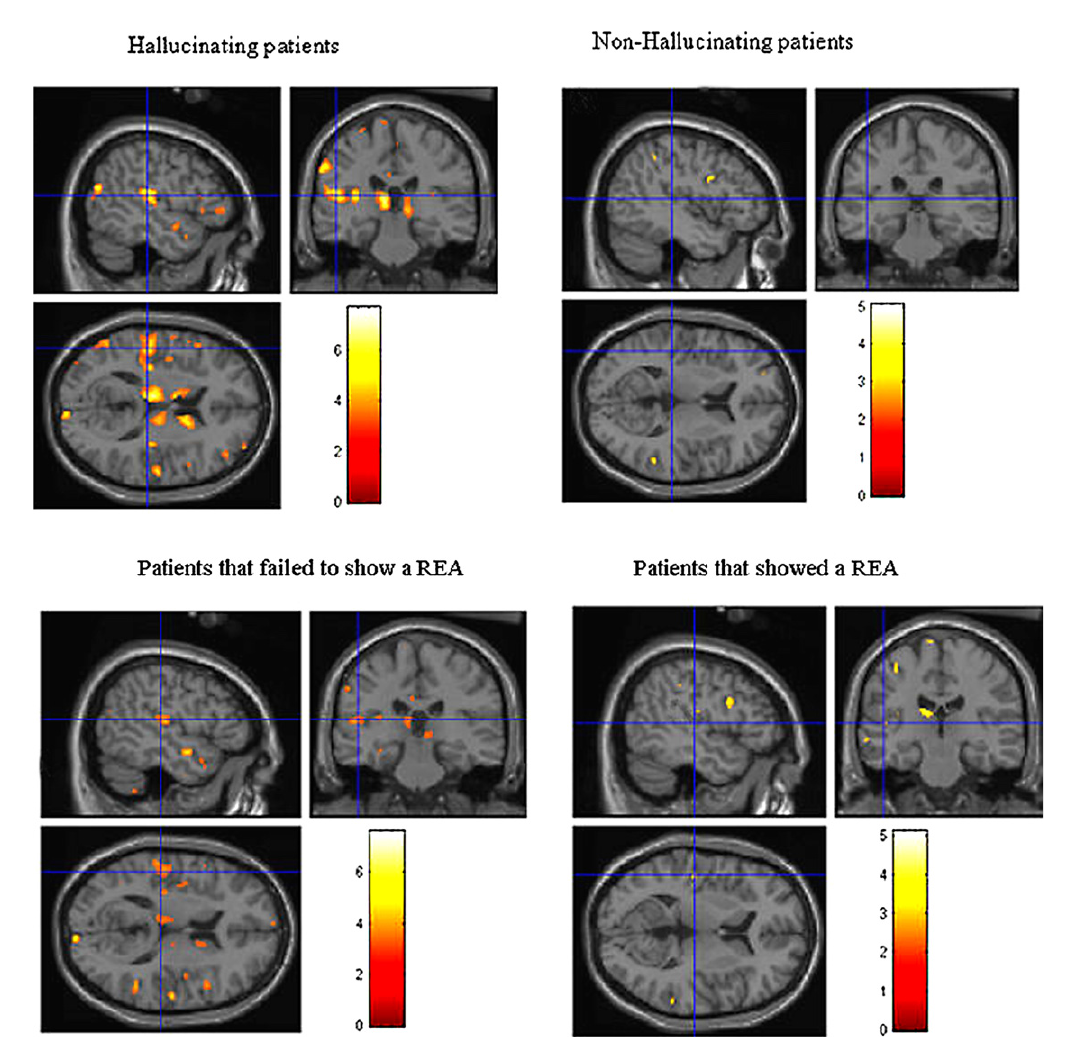
Figure 6. Colored areas show signifi cant reductions in grey matter density in the schizophrenia patients compared to healthy control subjects. The upper panel shows the sub-group of hallucinating (left) and non-hallucinating (right) patients compared to controls. The lower panel shows the sub-groups of patients that failed (left) respectively managed (right) to show a REA on a dichotic listening